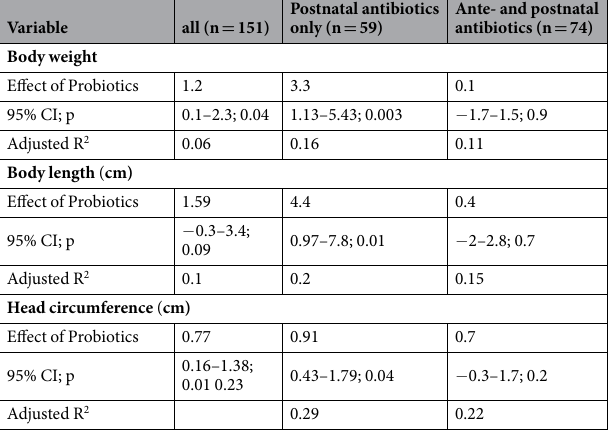
Table 8. Effect of probiotics on growth parameters at 5 years of age. Linear regression analysis included gestational age per week, birth weight in 100 g steps, gender, multiple birth, maternal descent and exposure to Bifidobacterium infantis / Lactobacillus acidophilus probiotics. The effect of probiotics on weight gain as g/d growth rates in mm/d is shown as B coefficient, 95% confidence interval and p-value. Adjusted R 2 values indicate coefficients of determinations and adjust for the number of terms used in the